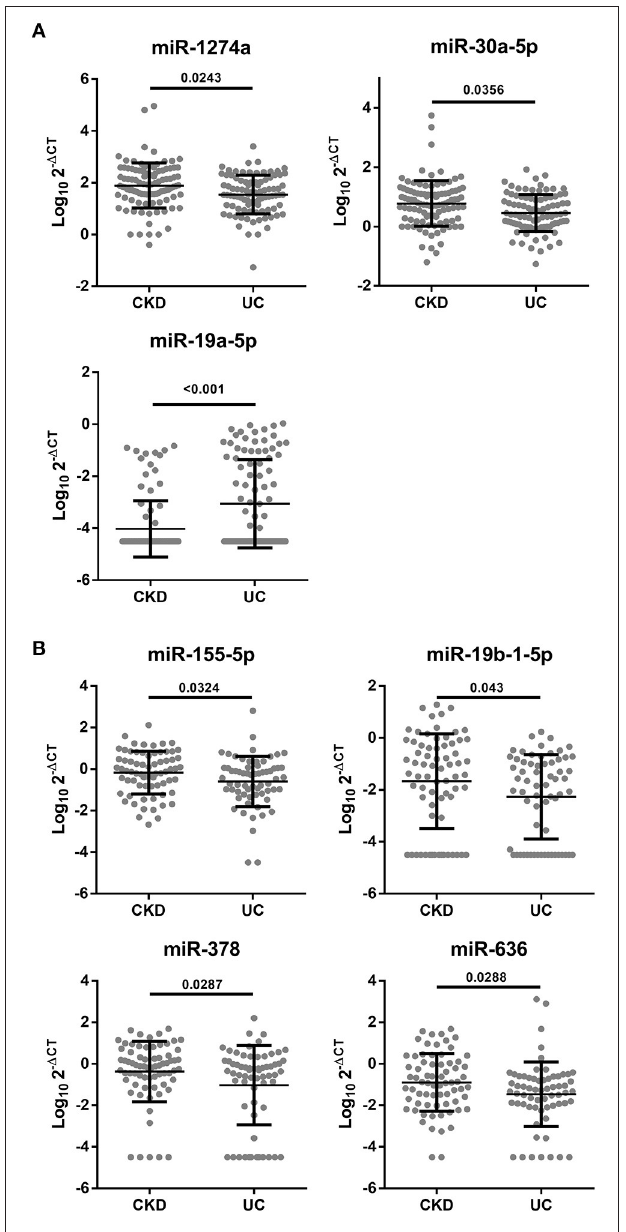
FIGURE 1 | Significant different miRNA expressions in the urine or plasma between CKD and CKD + UC. (A) miRNA levels from the urine of patients detected by qRT-PCR using RNU6 as a control ( n = 200). (B) miRNA levels from the plasma were detected by qRT-PCR using RNU6 as a control ( n = 134). The Y axis presents the expression level (Log10 2- 1 CT). CKD, patients with chronic kidney disease. CKD + UC, the urothelial carcinoma patients with CKD. The p -value was analyzed by Student’s t -test for each miRNA.